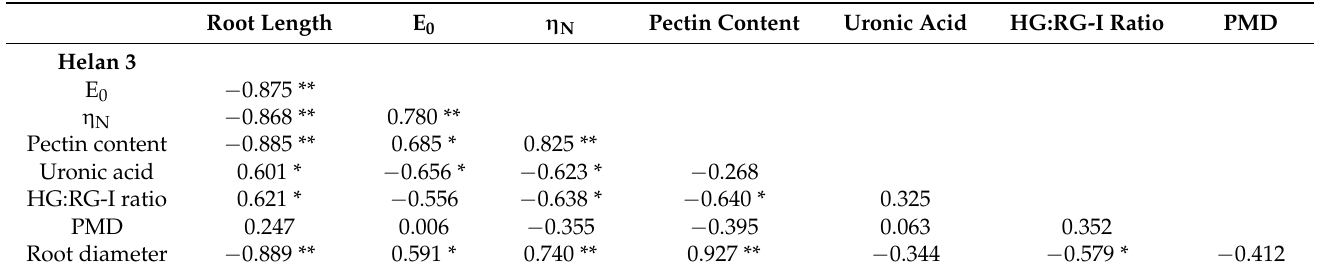
Table 3. Cross-correlation coefficients of final root length, elastic moduli (E 0 ), viscosity coefficient ( η N ), pectin content in cell wall, molar proportion of uronic acid in pectin, HG:RG-I ratio and degree of pectin methyl-esterification (PMD) of root cell wall in spinach under salinity